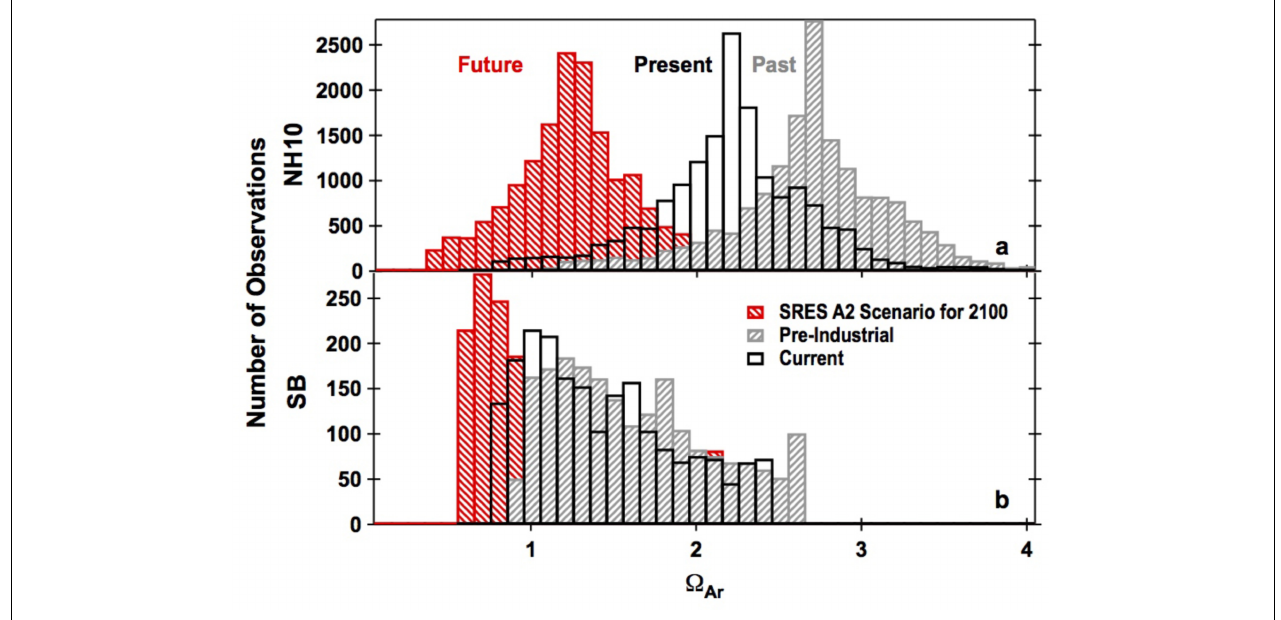
FIGURE 6 | (Top) Distribution of aragonite saturation data (open bars) calculated from in situ pH and pCO 2 measurements collected over 5 years at the Newport Hydrographic Line mooring (NH-10) off the Oregon coast (United States). The gray and red bars represent estimates from these data using pre-industrial and future CO 2 levels. (Bottom) The saturation states at the Oregon shelf break at 116 m depth. Adapted from Harris et al.